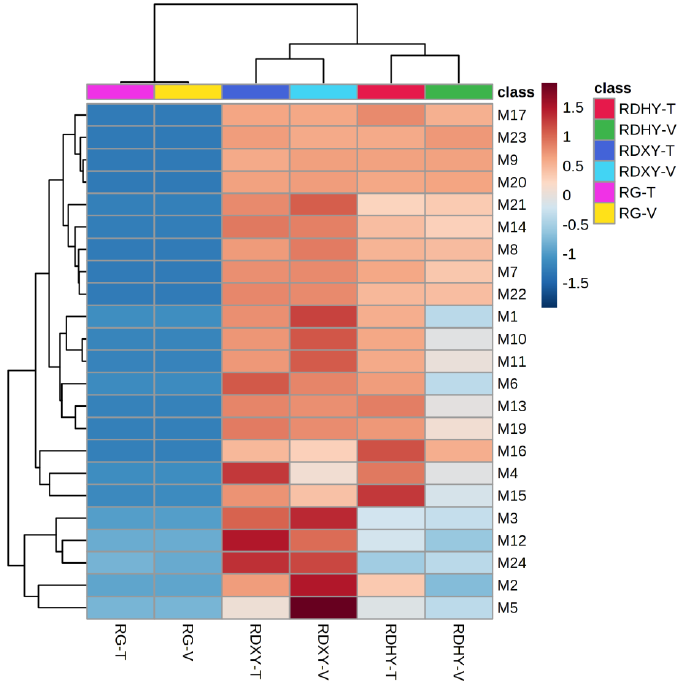
Figure 3. Hierarchical clustering analysis of the effects of trellis systems on the monoterpene contents of 3 table grape cultivars. The color of box represents the value of monoterpene content. Each line represents a compound, and each column represents a treatment. A red box represents a higher content than the average value, and a blue box represents a lower content. Note: RDHY, ‘RuiduHongyu’; RDXY, ‘RuiduXiangyu’; RG, ‘Red Globe’; T, the T trellis system; V, the V trellis system.